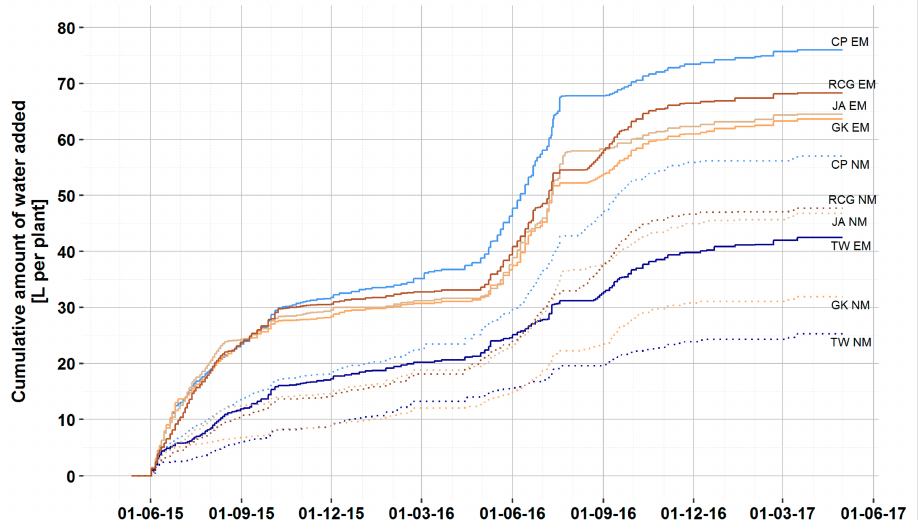
Figure 3. Cumulative representation of the amounts of water added to the plants in the course of the experiment. Abbreviations of the plant names are as follows: cup plant: ‘CP’, tall wheatgrass: ‘TW’, giant knotweed: ‘GK’, Jerusalem artichoke: ‘JA’ and reed canary grass: ‘RCG’. Soil moisture treatments were abbreviated as ‘EM’ (excess soil moisture) and ‘NM’ (non-excess soil